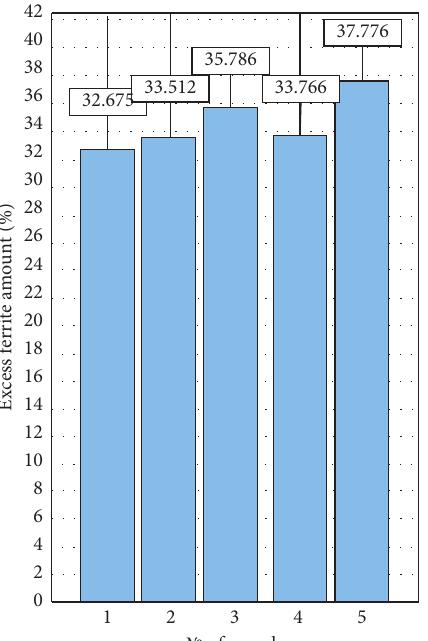
Figure 20: The distribution of excess ferrite amount in the deposited steel S 45 samples after treatment with high-frequency currents and normalization in the covering agent.